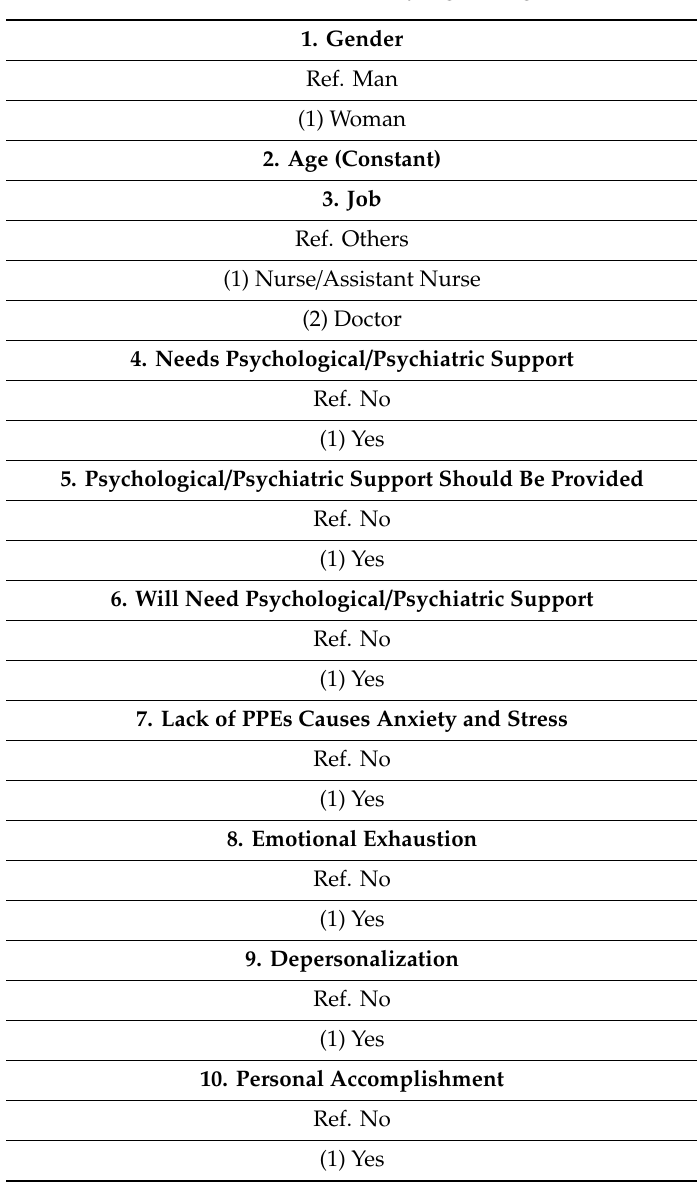
Table 2. Variables used in binary logistic